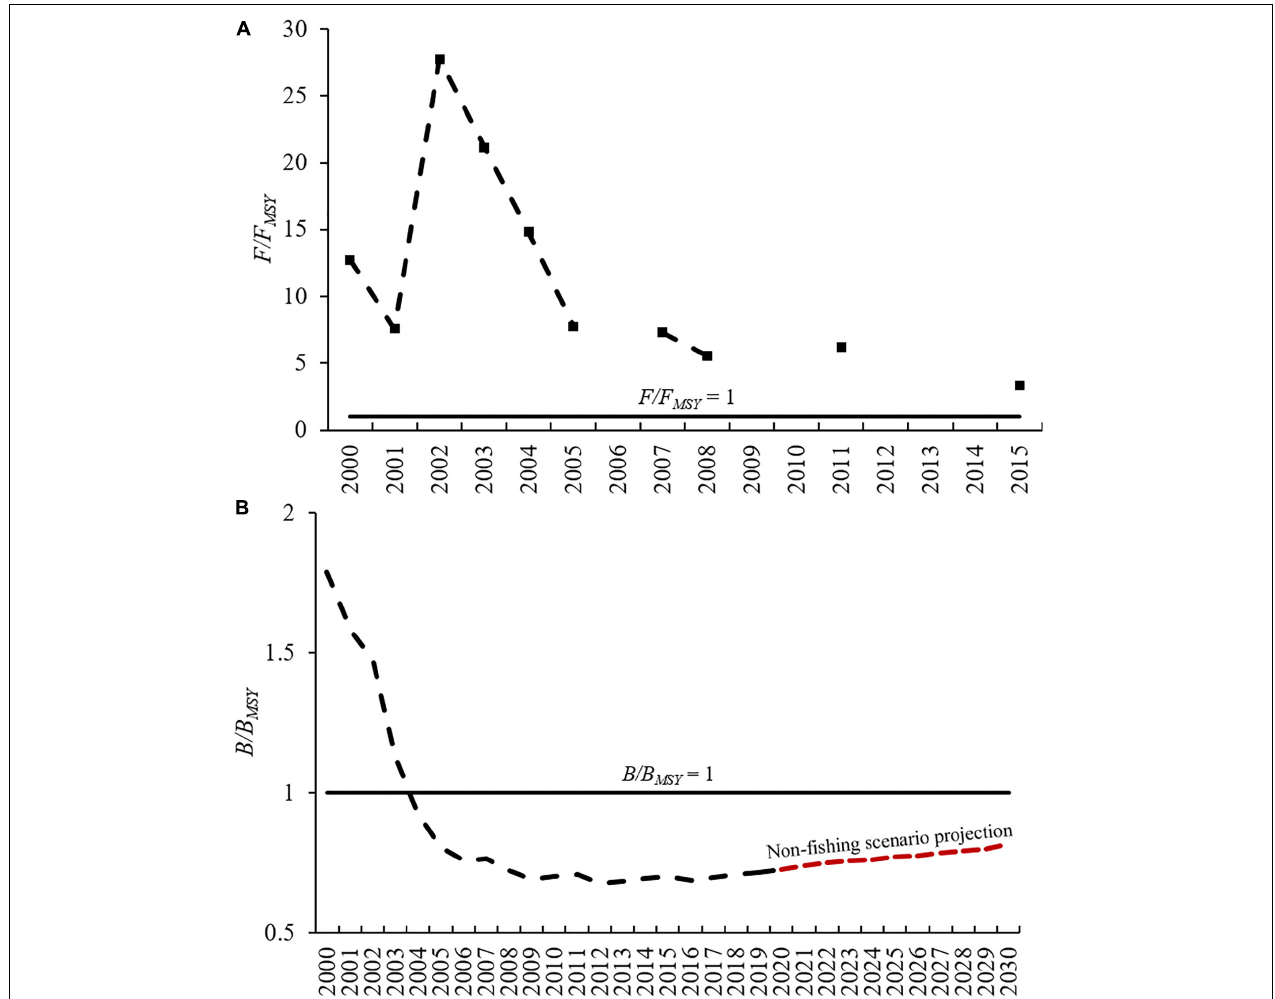
FIGURE 3 | Trajectories of F/F MSY (A) and B/B MSY (B) from Schaefer model for I. fuscus in the